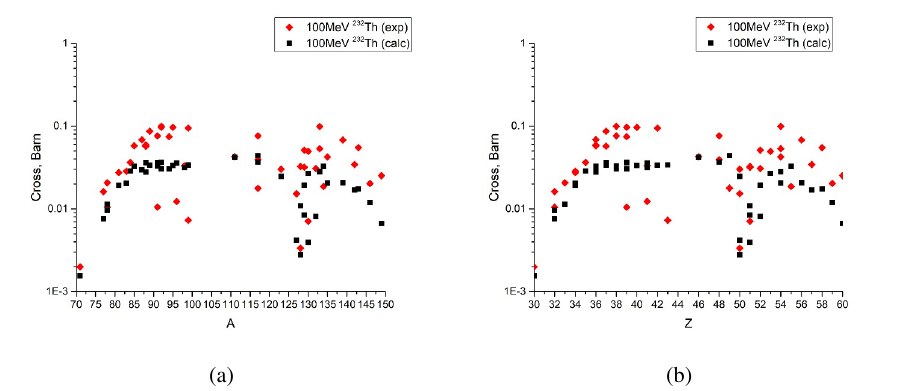
Figure 3: Graph of the cross sections for thorium irradiated by 100 MeV protons